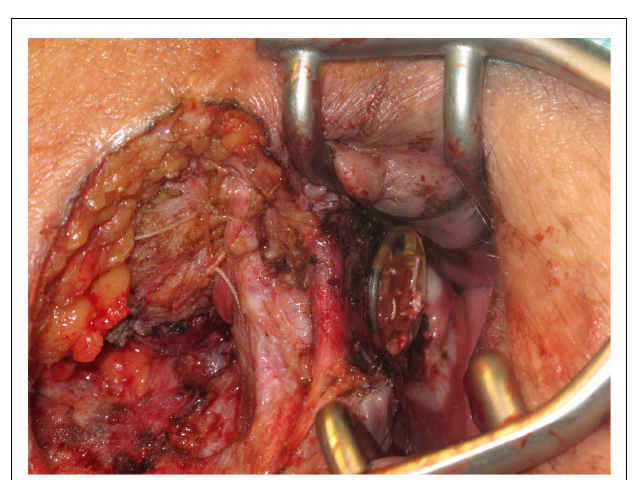
FIGURE 8 |The external end of the fistula plug is also secured with several absorbable single button sutures to the base of the wound of the limited fistulectomy